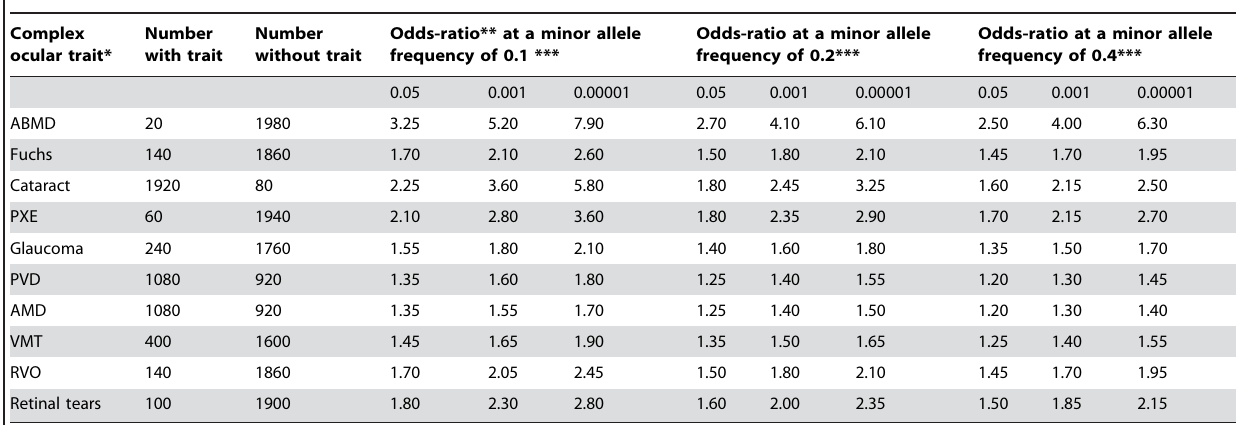
* Abbreviations and definitions are given in Table 1. ** Power was estimated assuming a log-additive genetic model, significance levels of 0.05, 0.001, and 0.00001, complete linkage disequilibrium between the single nucleotide polymorphism (SNP) studied and the genetic variant underlying the association, and the population prevalence estimates shown in Table 1. *** The three significance levels, namely 0.05, 0.001, and 0.00001, refer to testing one variant, multiple variants in a single gene, and variants across the genome, respectively.